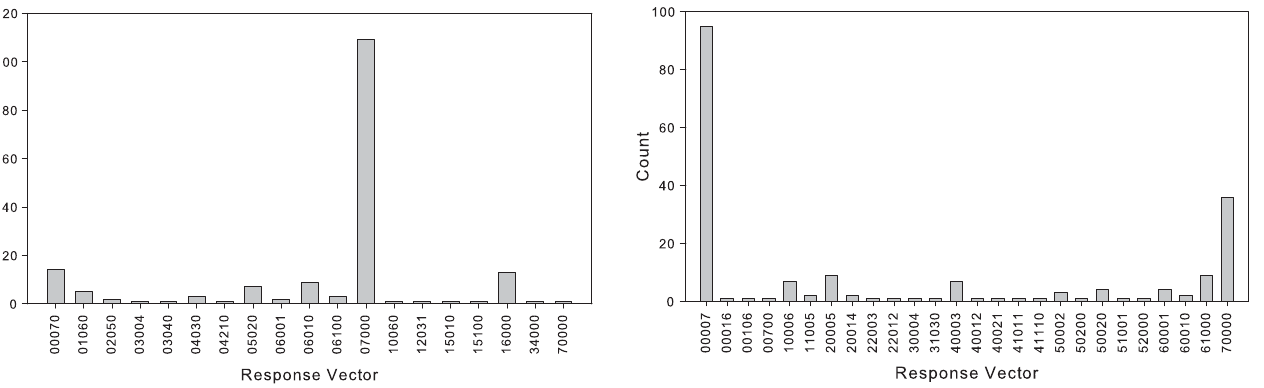
FIG. 5. Distribution of response vectors for Spring 2006 postt- est data.